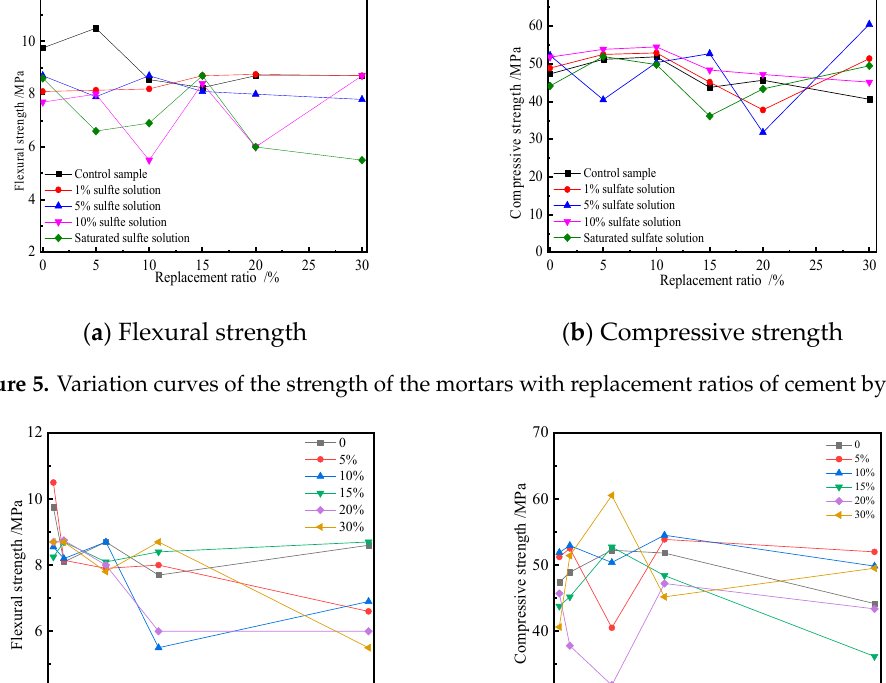
Figure 5. Variation curves of the strength of the mortars with replacement ratios of cement by slag.